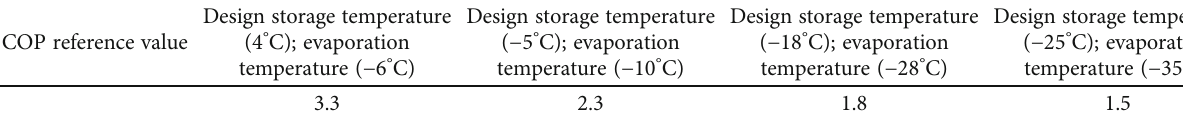
Table 5: COP reference value for calculating energy consumption coe ffi cient.